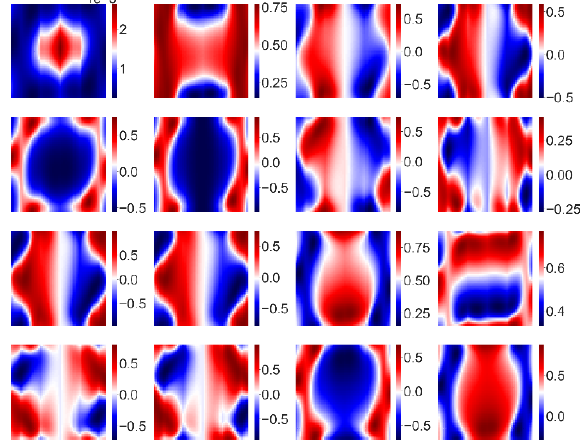
Fig. 3. Simulation of the Mueller matrix images at a wavelength of 500 nm with the structure parameters: h = 600 nm, p = 1000 nm, d = 460 nm, θ =